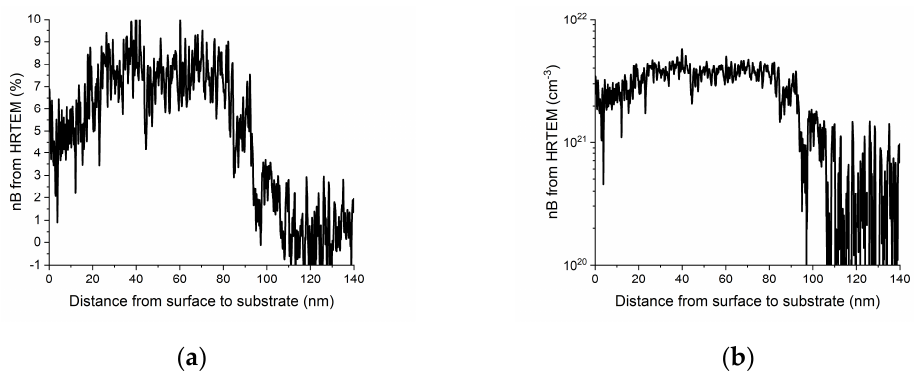
Figure 7. One-dimensional depth distribution of B in the same Si:B sample (as in Figure 6) measured from HRTEM images by the Strain++ method [21]. ( a ) Linear scale concentration (at%) to better show details. ( b ) Logarithmic scale (atom/cm 3 ) more usual presentation in semiconductor physics.